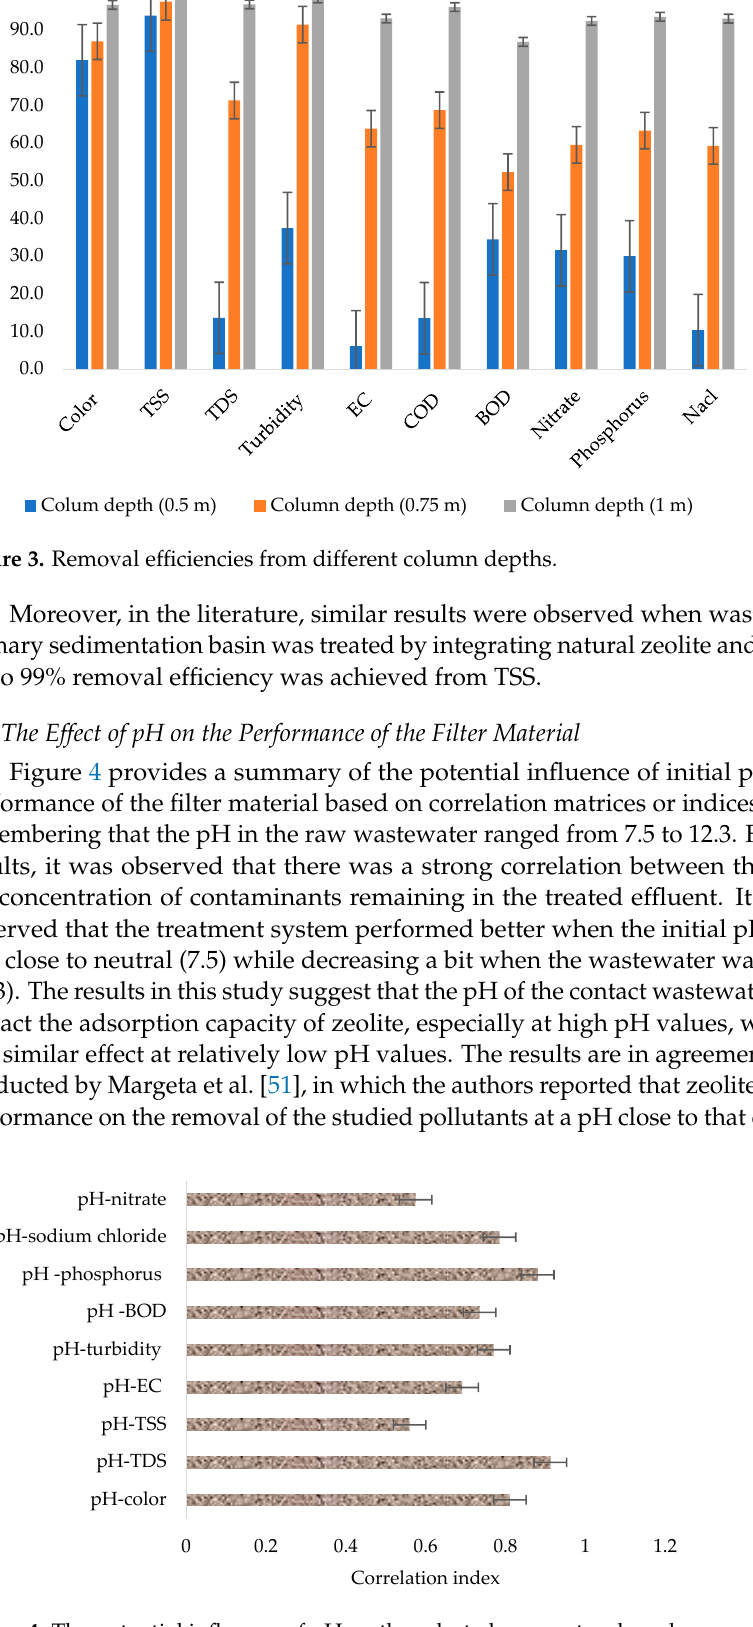
Figure 4. The potential influence of pH on the selected parameters based on correlation indices.